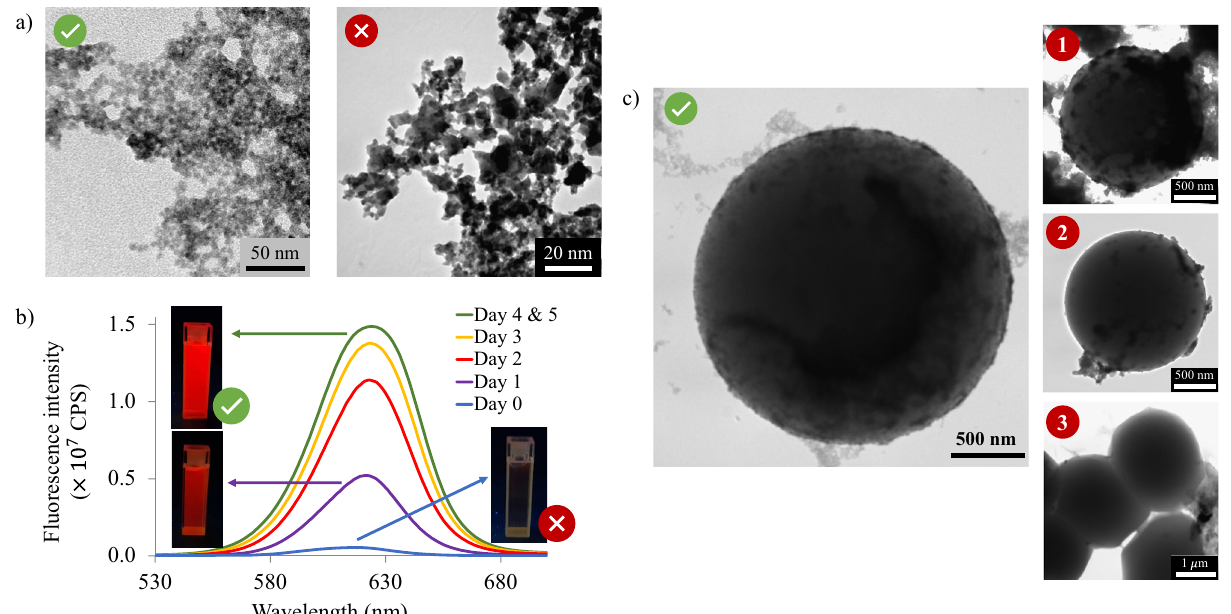
Figure 2. Optimisation steps when preparing the QD-tagged beads. ( a ) TEM images of purified (left) and crude (right) L-cysteine capped CdSe/ZnS QDs. ( b ) Fluorescence intensity recovery of L-cysteine capped CdSe/ ZnS QDs over five days. The photo insets show the appearance of the sample under UV-light on certain days. ( c ) The TEM image on the left shows a QD-tagged bead uniformly coated with QDs, whereas insets 1–3 show QD-tagged beads when some synthesis steps were not carried out optimally. In inset 1 the excess EDC was not removed before adding the QDs, inset 2 shows the reaction done with magnetic stirring as opposed to ultra- sonication and inset 3 shows the deformation of the polymer beads due to the presence of